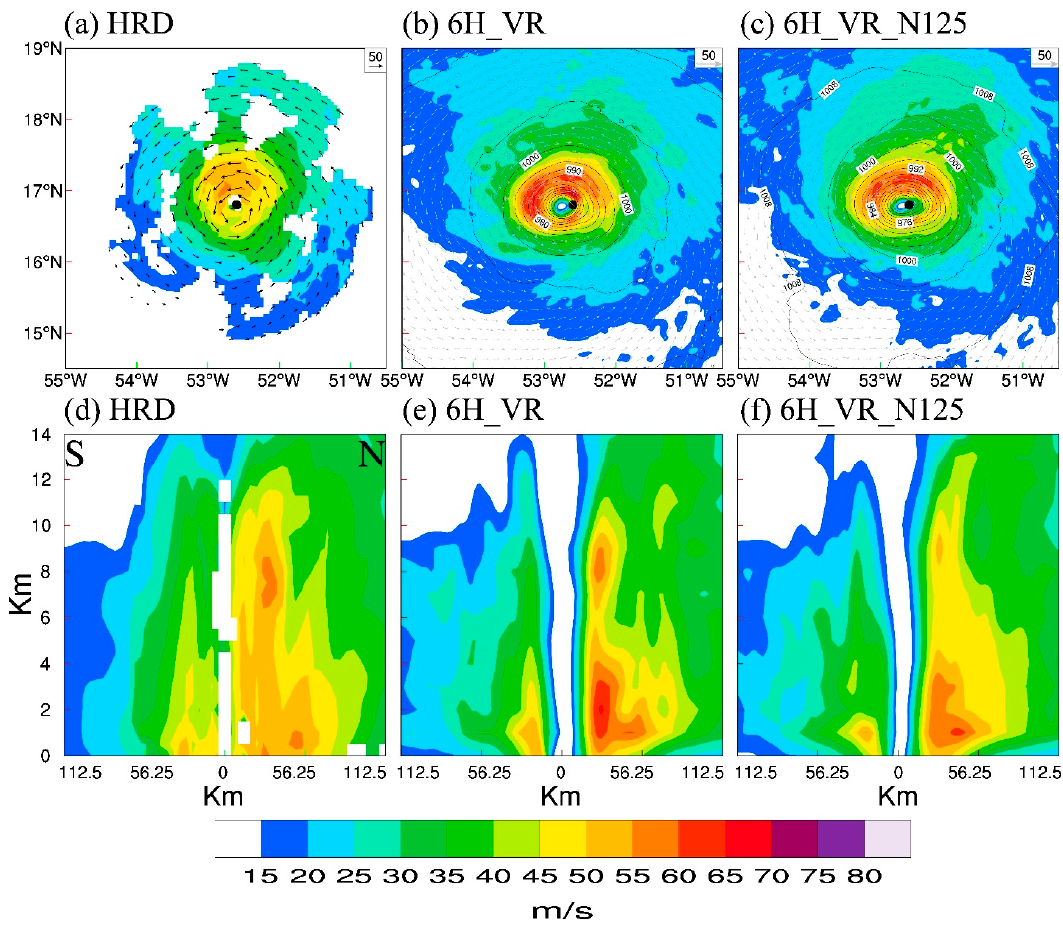
Figure 5. Same as Figure 3, except for ( b , e ) “6H_VR” and ( c , f ) “6H_VR_N125”. When “6H_VR” and “6H_VR_N125” are compared, the additional assimilation of inner-core AMVs in “6H_VR” outperforms “6H_VR_N125” in the analysis by better cap- turing the height of the aloft wind maximum and a clearer pattern of the double eyewall (Figure 5). Figure 6 shows the azimuthal mean radial wind analysis valid at 12:00 UTC, 5 September 2017, for “6H_VR” and “6H_VR_N125”. At this stage of the storm, Irma was reaching its peak intensity and maintained category 5 intensity until it hit Barbuda about 18 h later (Figure 1a). Therefore, Irma should be a mature storm that fits the typical storm structure with a strong low-level inflow, as well as a strong and high upper-level outflow. “6H_VR” produces a slightly weaker but thicker upper-level outflow than “6H_VR_N125” (Figure 6a,b). Such a feature is due to the inner-core AMVs trying to pull the outflow max- ima to a higher level, which shows a better match with the outflow observations around 100 hPa in both pattern and strength (Figure 7a,b). Consequently, “6H_VR” produces better Vmax and MSLP predictions than “6H_VR_N125” (Figure 4). The improvement includes alleviated spin-down issues, as shown in Figure 4d vs. Figure 4g. “6H_VR” also produces better long-term intensity predictions during the weakening stage than “6H_VR_N125” (Figure 4d,e,g,h). Nevertheless, the track predictions are overall comparable between the two experiments (Figure